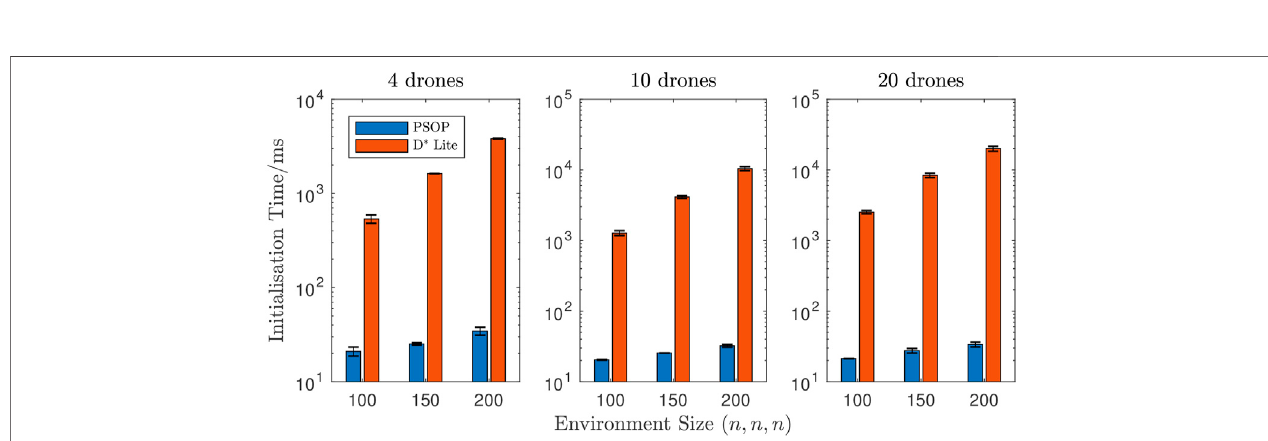
FIGURE 9 | Mean time taken to initialise by environment size. Across all nine scenarios, p-drones were shown to require far less initialisation time than d-drones. Figureshows far higher initialisation time, which increases asfunction of environment size and number of drones, when using D* Lite. Forp-drones, the initialisation time increased by 60.2 % (on average across all drone system sizes) from environment size of (100 × 100 × 100) to environment size of (200 × 200 × 200) whereas d-drones sawanaverageincreaseof693.0 % forthesameincreaseinenvironmentsize.Additionally,forp-dronestheinitialisationtimeincreasedby2.0 % (onaverageacross all environment sizes) from a system of 4 drones to a system of 20 drones whereas d-drones saw an average increase of 417.8 % for the same increase in number of drones.